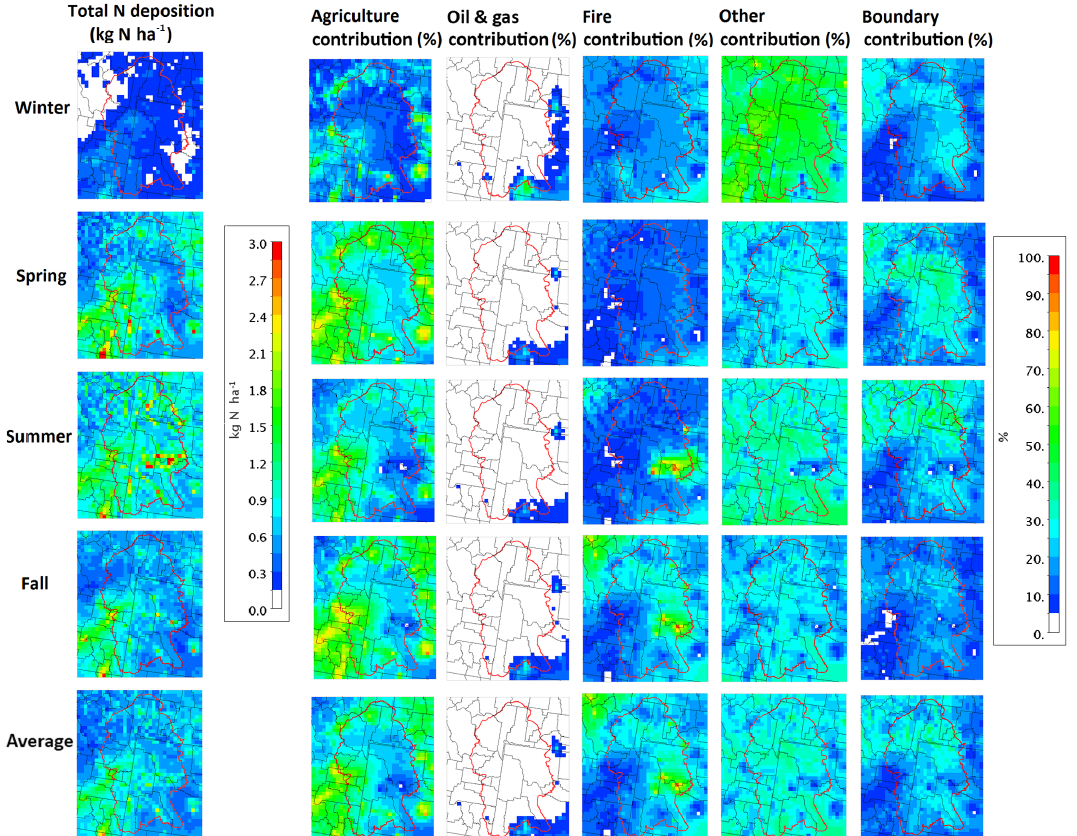
Figure 8. Seasonal patterns of different source sectors’ (agriculture, oil and gas activities, fires, others (e.g., anthropogenic, biogenic, light- ning, and boundary conditions)) contributions to total N r deposition over the GYA in 2011. The first column is the total seasonal N r deposition patterns in kgNha − 1 while the following five columns are the seasonal patterns of relative contributions from different source